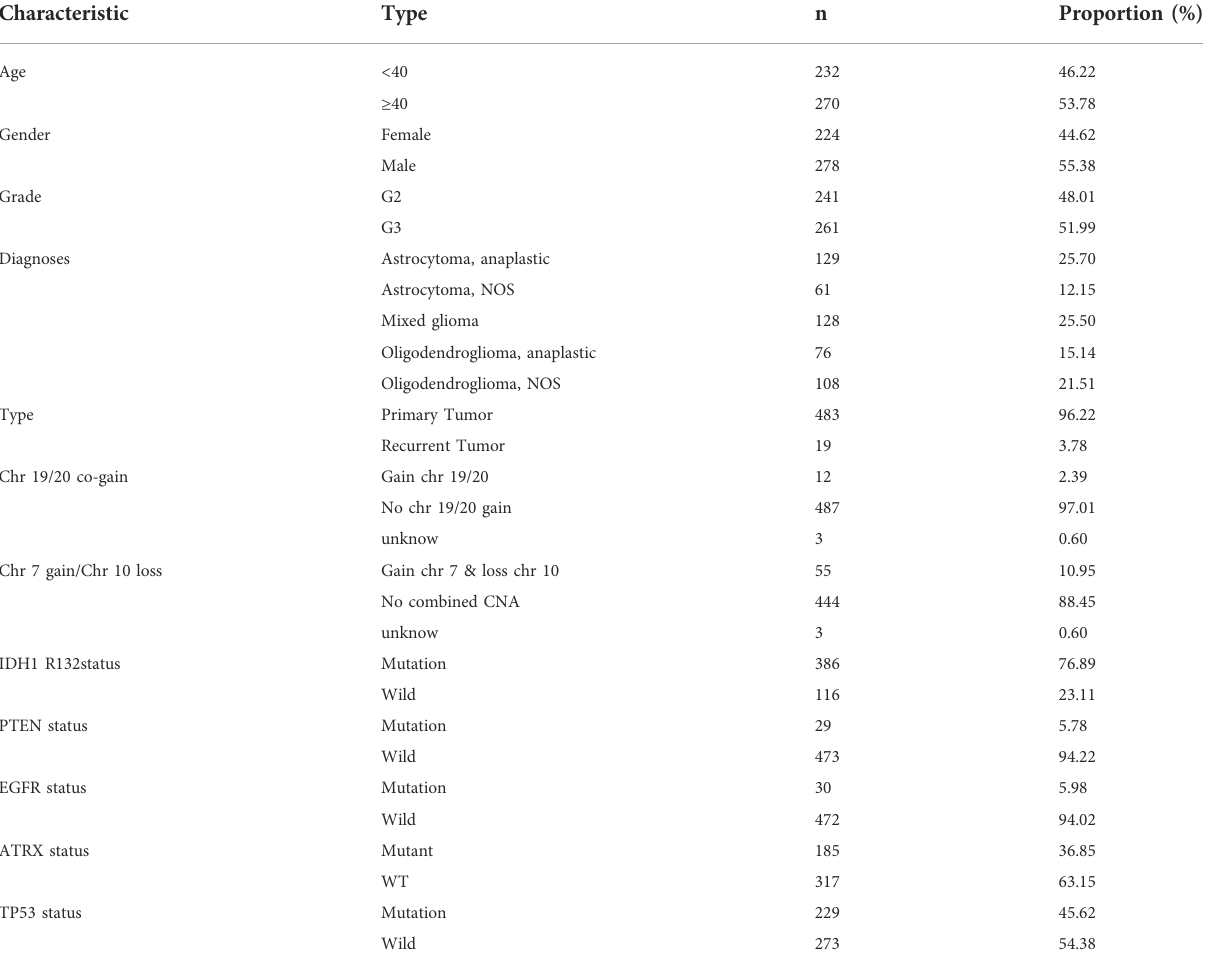
TABLE 1 Baseline data of all LGG patients.